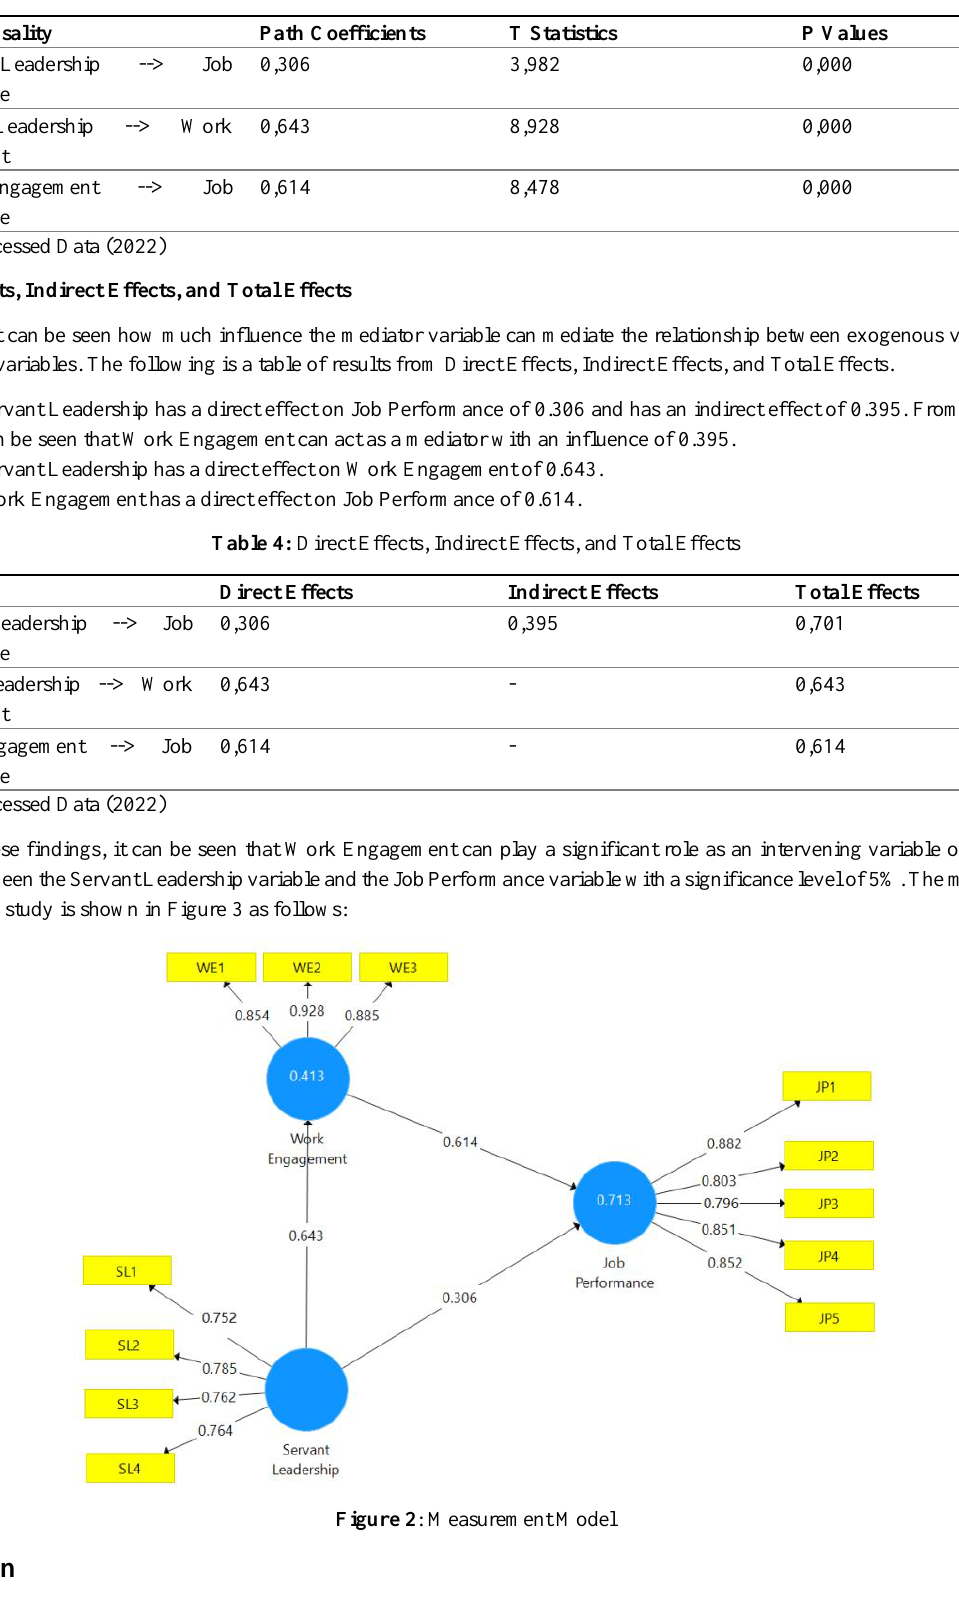
Table 3: Model Causality Test